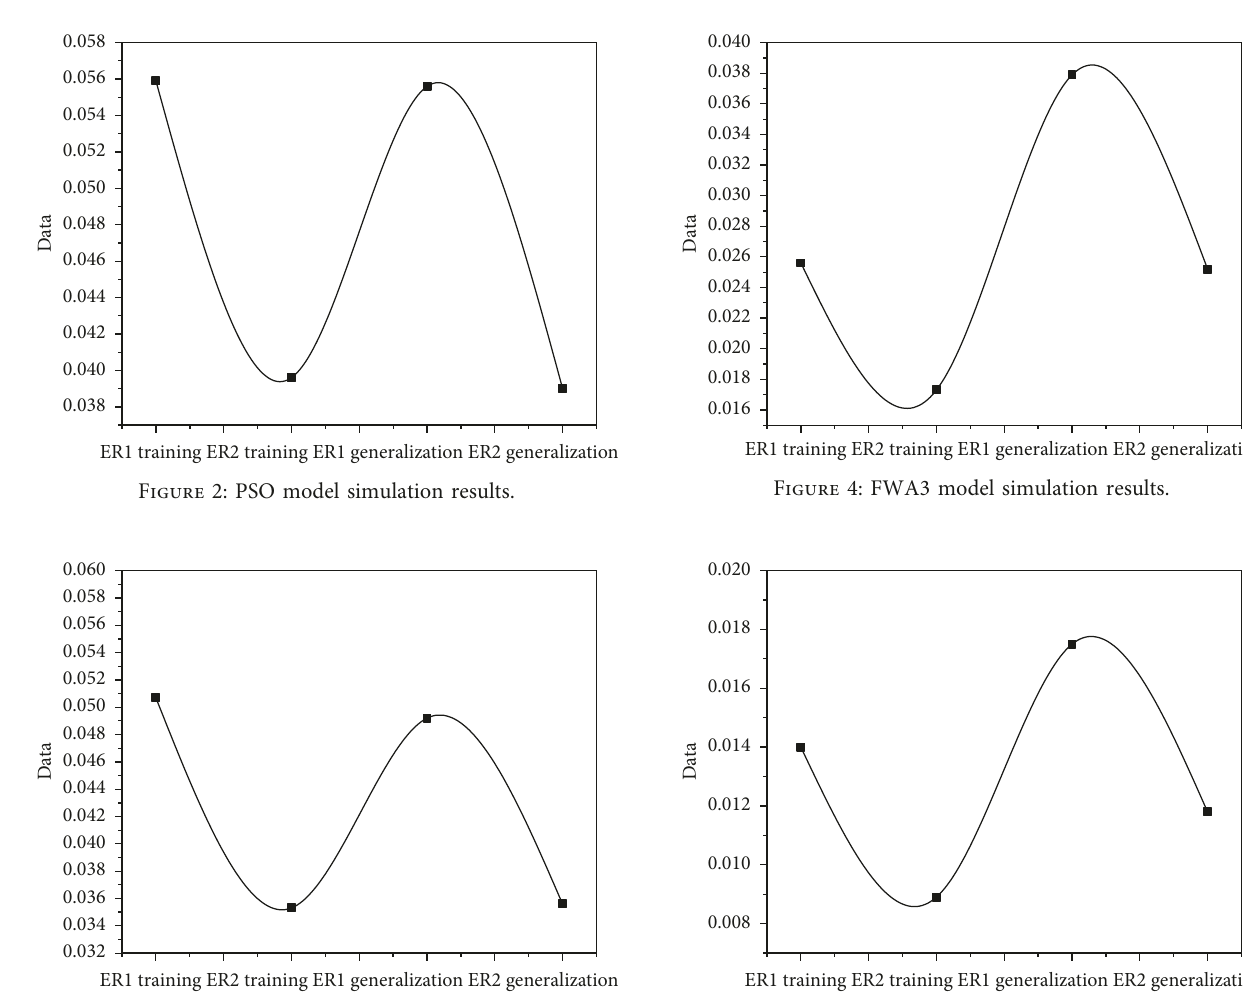
Figure 5: CFWA model simulation